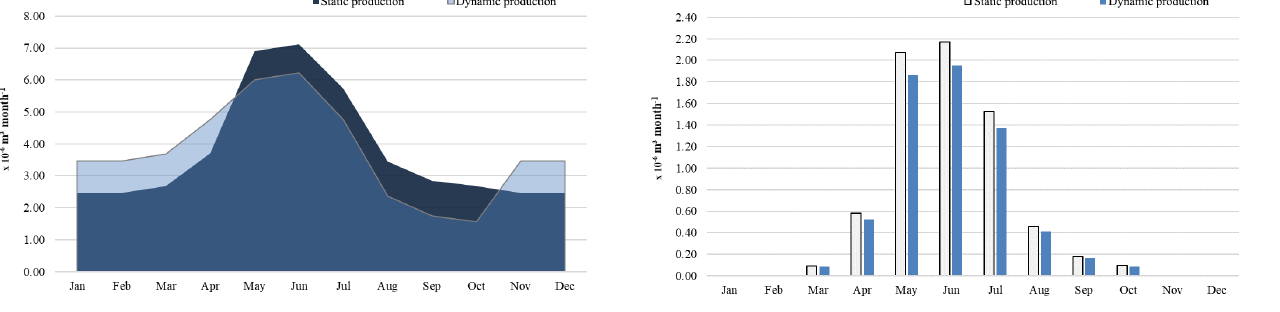
Figure 6. Monthly water supply from Aït Messaoud Dam. Figure 7. Monthly groundwater use by static and dynamic produc- tion of phosphate slurries transported by pipeline.